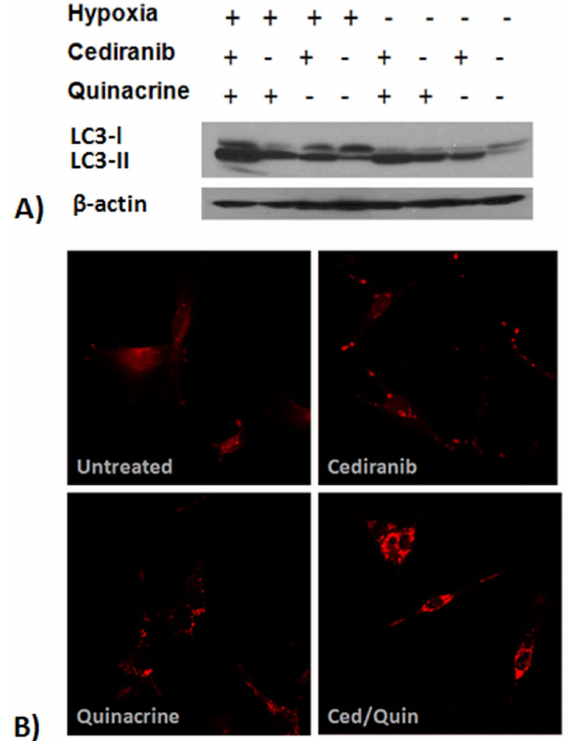
Fig. 2. The effect of hypoxia and cediranib/quinacrine on LC3. A) Representative LC3 western blots obtained from 4C8 cells grown under normoxic or hypoxic (0.5% O 2 ) conditions for 10 hrs while untreated or exposed to cediranib (3 m M), quinacrine (0.8 m M), or combined cediranib/quinacrine. B) RFP-LC3 expressing 4C8 cells were visualized using Zeiss LSM 780 laser scanning confocal microscope after incubation under hypoxic conditions for 24 hr while untreated or exposed to cediranib (2.5 m M), quinacrine (2.5 m M), or combined